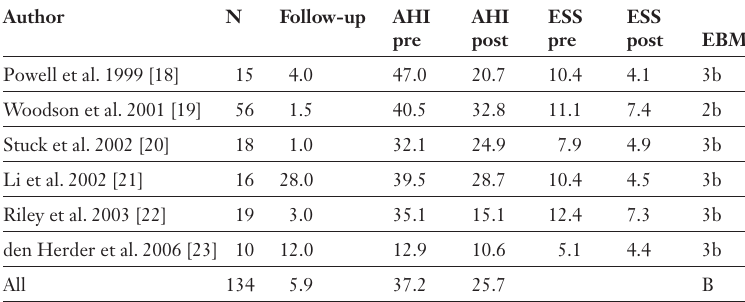
Efficacy of radiofrequency treatment of the tongue base in